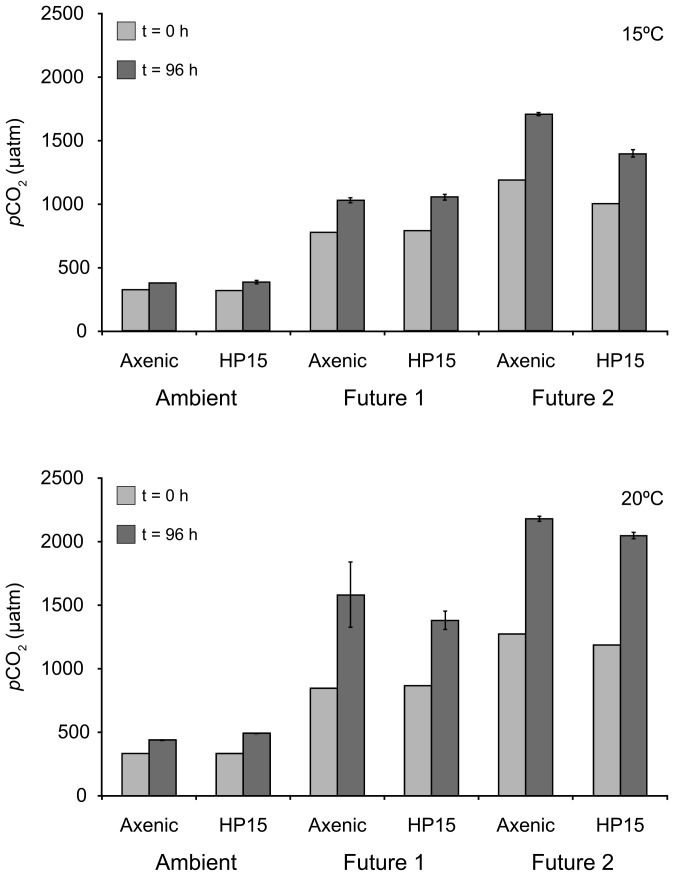
Initial and final pCO2 during the incubations at 15°C and 20°C.